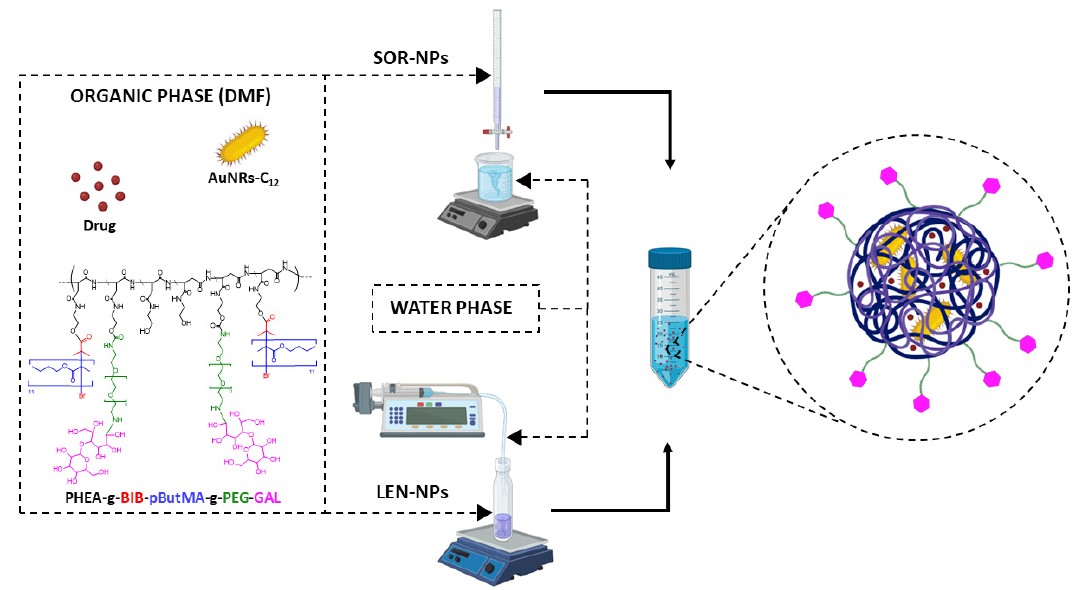
Figure 5. Schematic representation of the preparation of hybrid nanoparticles.